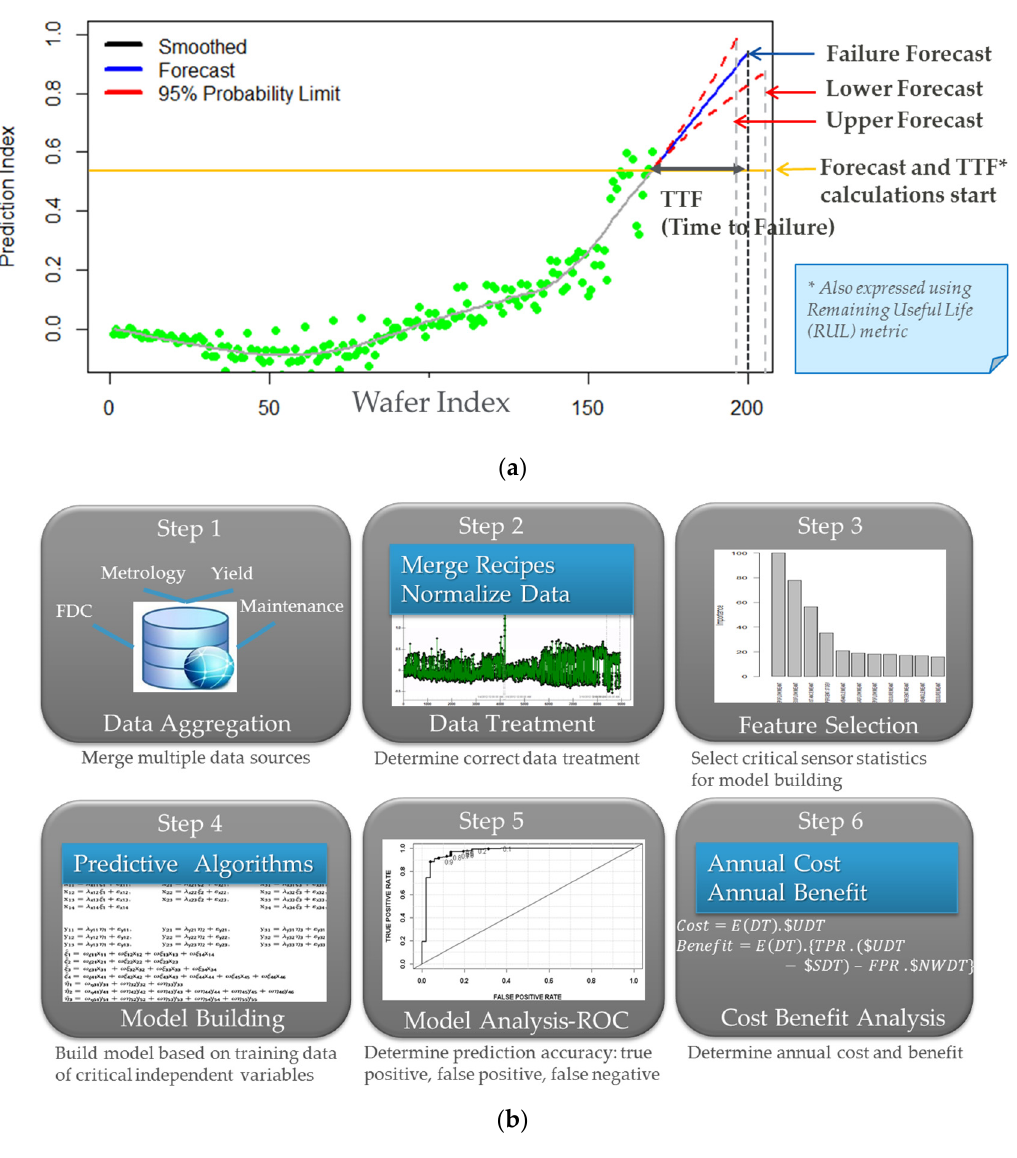
Figure 8. The approach to predictive maintenance: ( a ) the multivariate analysis (MVA) predictor and its components including time ‐ to ‐ failure horizon and some expression of prediction confidence or range; and ( b ) the off ‐ line model building and optimization approach that provides a mechanism for incorporating subject matter expertise (SME), and can be leveraged for many advanced process control (APC) predictive capabilities.